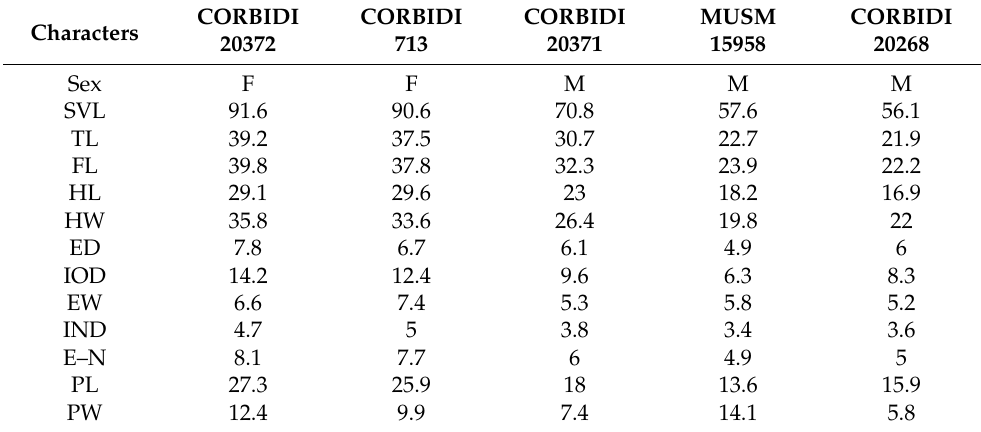
Table A1. Measurements (in mm) of adult male and female paratypes of Rhinella moralesi sp. nov.